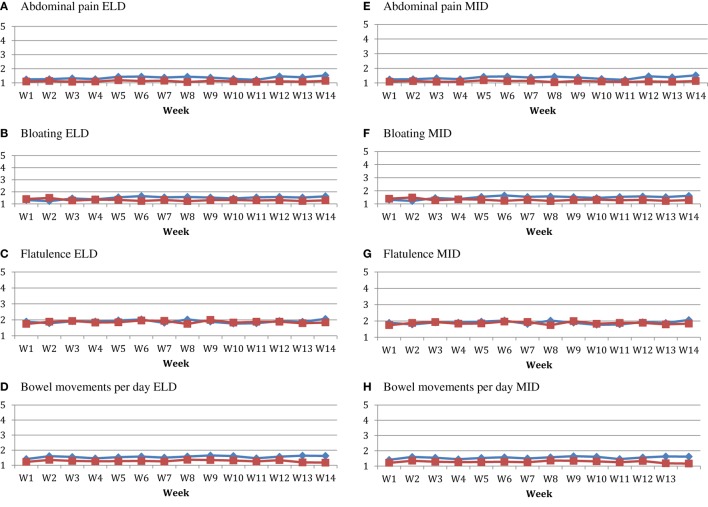
Tolerability of consuming MSPrebiotic® versus Placebo over time in elderly (ELD) and mid-age (MID) adults. All ELD (A–D) and MID (E–H) participants consumed 30 g placebo/day for 2 weeks and then were randomized to continue placebo or consume 30 g MSPrebiotic®/day for the remaining 12 weeks of the study. For abdominal pain, bloating and flatulence the scale was from 1 (none) to 5 (extreme). The red square symbols represent the placebo group, and the blue diamond symbols represent the MSPrebiotic® group. There was no statistically significant difference between groups for any of these parameters. (A) Abdominal pain ELD. (B) Bloating ELD. (C) Flatulence ELD. (D) Bowel movements per day ELD. (E) Abdominal pain MID. (F) Bloating MID. (G) Flatulence MID. (H) Bowel movements per day MID.